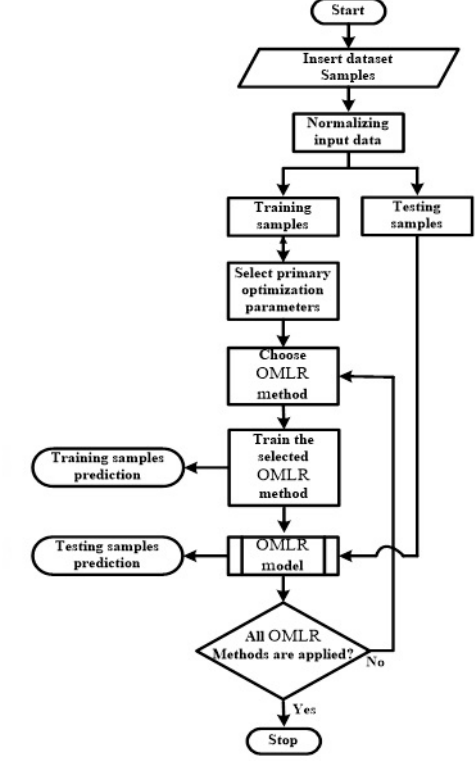
Figure 3. Solution methodology Flowchart.